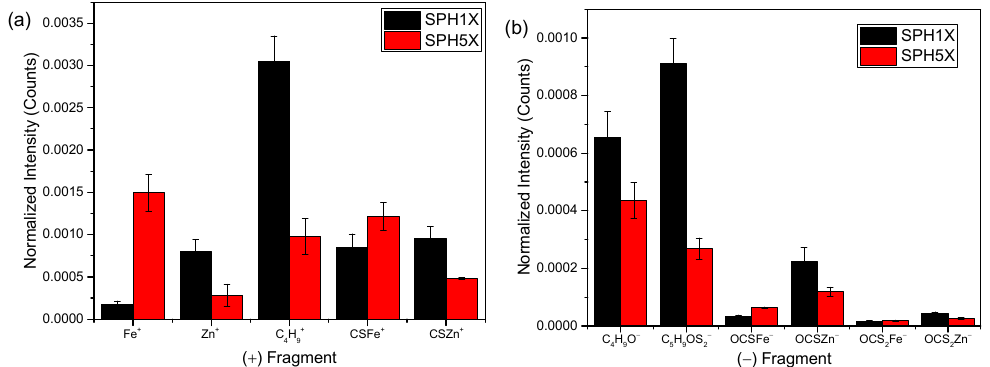
Figure 4. Normalized intensity of fragment ions for BX absorbed sphalerite (SPH1)/marmatite (SPH5): ( a ) positive fragment ions and ( b ) negative fragment ions; the black histogram is the BX absorbed sphalerite and the red histogram is the BX absorbed marmatite.